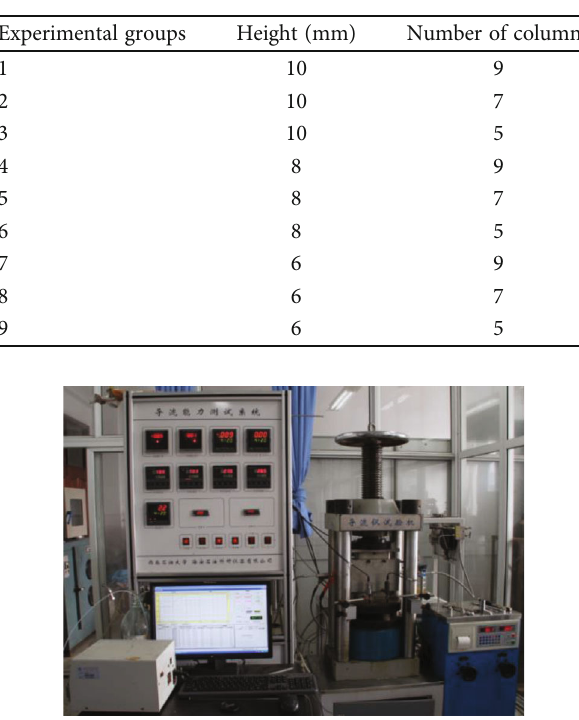
Table 2: Experimental groups.